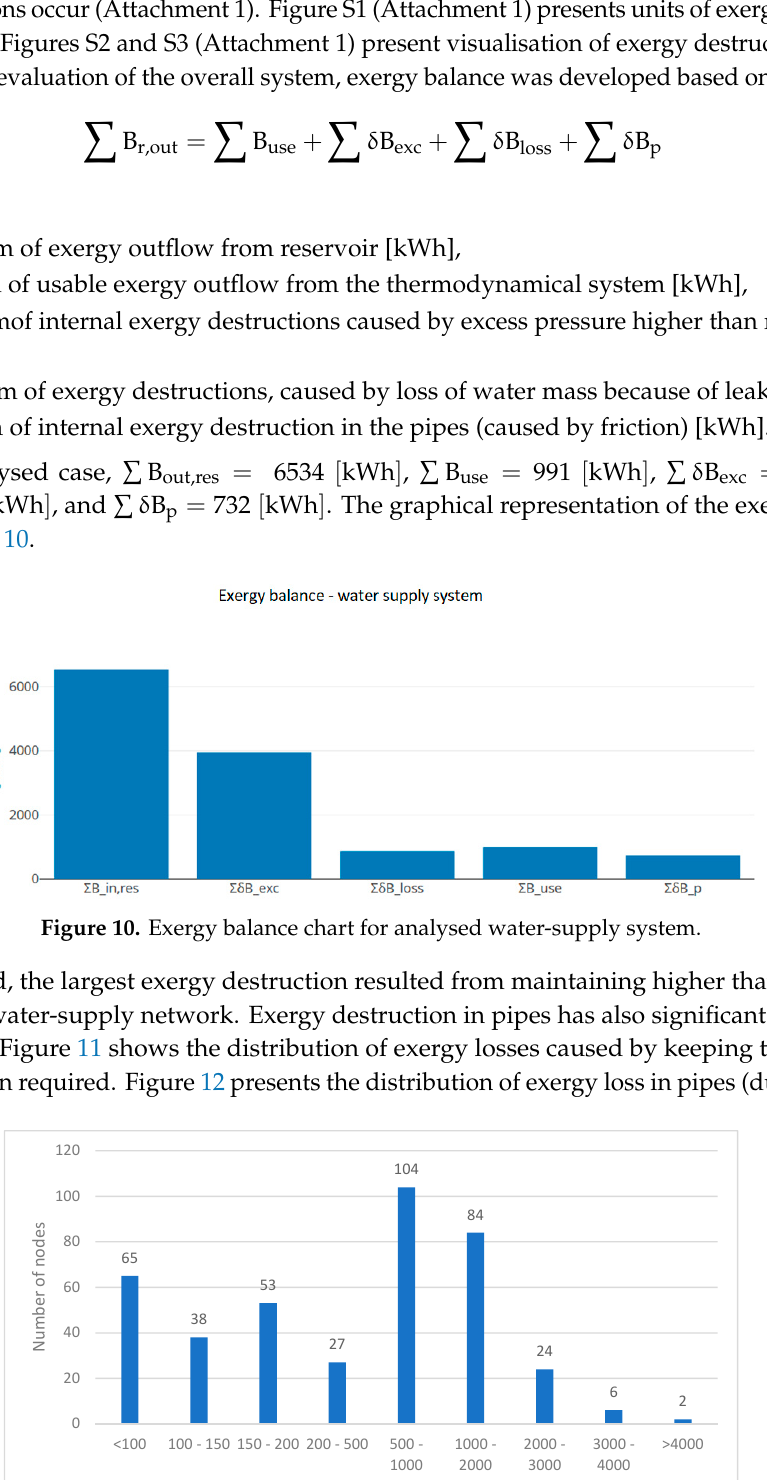
Figure 12. Distribution of exergy destruction in pipes. 4.2. Water Treatment Plant In the second case, the exergy balance for a water treatment plant was conducted, consisting of a water intake area, treatment station, and pumping station. Water intake consisted of two wells. Water from the wells was transported by pipe systems to a water treatment station, where it was aerated (in a closed aerator), and then pumped through filters to the clean water tank. From the clean water tank, it was pumped to the water distribution system by a second stage pumping station. Figure 13 shows a diagram of the analysed water treatment plant.